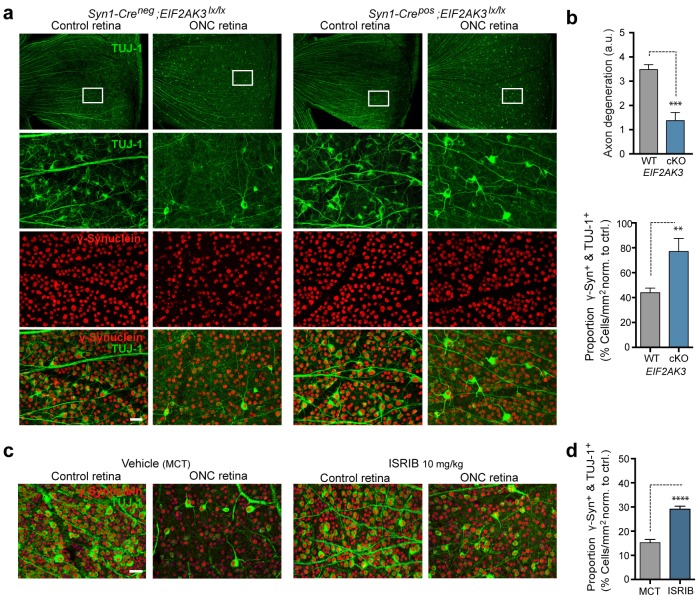
PERK contributes to neurodegeneration following nerve injury.(a–b) Reduced loss of PERK-deficient RGCs 14 d after ONC. (a) TUJ-1 (green)/ γ-synuclein (red) immunolabeled whole mount retinas from control Syn1-Creneg;Eif2ak3lx/lx (PERK WT) and neuronal PERK-deficient Syn1-Crepos;Eif2ak3lx/lx (PERK cKO) mice 14 d after ONC, high magnification (expanded from boxed region). (b) Blinded scoring of axon degeneration from 0–5 in whole-mounted retinas and automated image quantification of TUJ-1/γ-synuclein double-immunolabeled RGCs normalized to uncrushed retina of each mouse (n = 8 WT, n = 6 PERK cKO). (c–d) Reduced loss of RGCs 10 d post-ONC in ISRIB-treated mice (10 mg/kg ISRIB in MCT vehicle b.i.d) compared to vehicle control. (c) Automated image analysis of TUJ-1 (green, outlined in cyan)/ γ-synuclein (red, outlined in blue) immunolabeled cells. (d) Quantification of TUJ-1/γ-synuclein double-immunolabeled RGCs (outlined in green) in crushed retinas normalized to uncrushed control (n = 8). Scale bars = 25 µm. Student’s t-test was used for statistical analysis. Data are mean ± SEM. **p<0.01, ***p<0.001, ****p<0.0001.